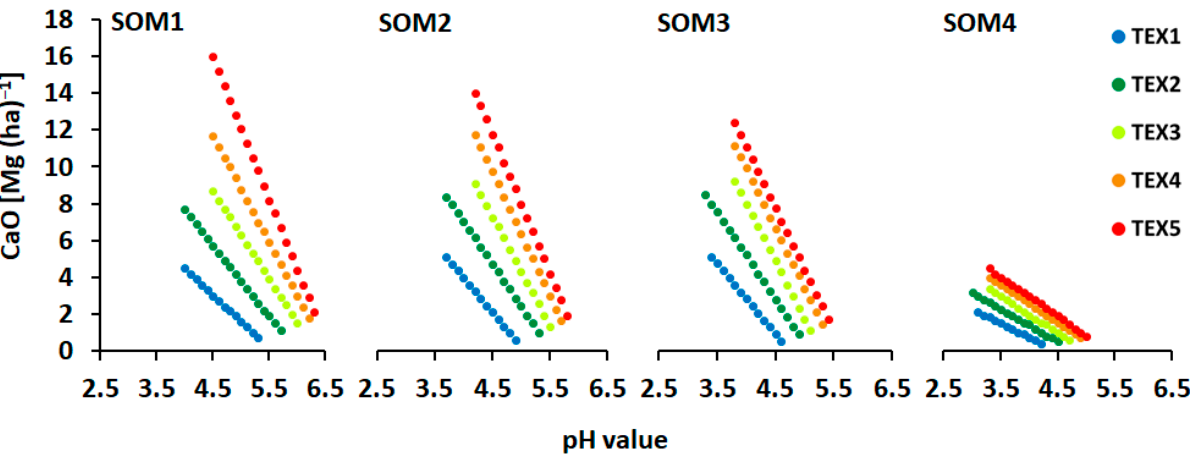
Figure 2. CaO amounts recommended by VDLUFA to increase the pH value from suboptimal statuses to the optimum pH ranges, depending on the SOM and soil texture classes. The given pH ranges correspond to the lime supply statuses A and B (compare Table 1 and Figure 1). The recommendation is usually related to a period of 4 years (one crop rotation).